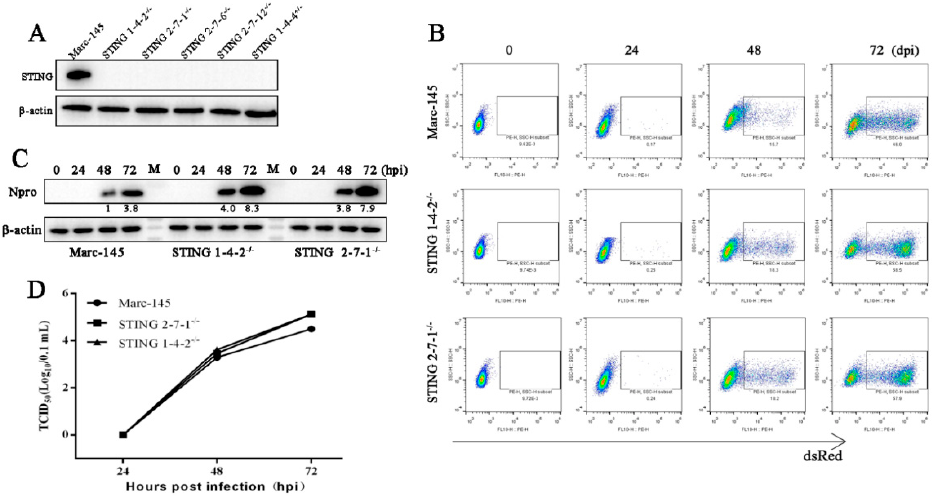
Figure 3. The replication of PRRSV in STING − / − Marc-145 cells. ( A ) Detection of STING protein expression in 4 STING − / − Marc-145 cell clones and 1 STING +/ − Marc-145 cell clone by Western blotting. ( B – D ) Two STING − / − cell clones and control Marc-145 cells in 24-well plates were infected with rXJ17-5-dsRed at a MOI of 0.1. Cells were harvested at 0, 24, 48, and 72 hpi, and analyzed by flow cytometry. The dsRed signal represents the Marc-145 cells infected by PRRSV ( B ). The expression of PRRSV N proteins (Npro) was detected by Western blotting ( C ). Viral titers in the supernatants were assayed by TCID50 ( D ).